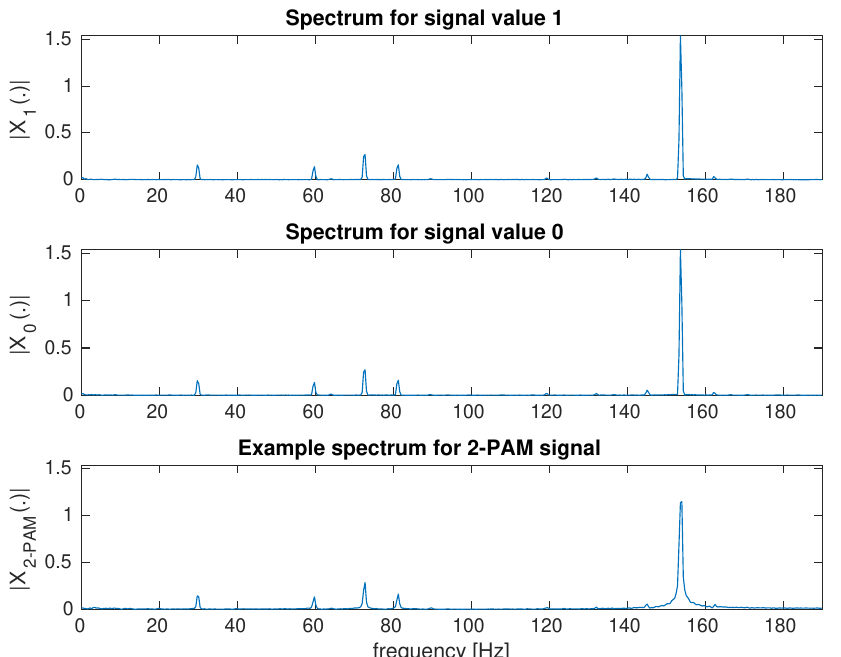
Figure 17. Signal spectra for the average brightness of the frames of the video sequence. Spectra for two brightness levels and a random transmitted sequence with 2-PAM modulation are shown. Brightness modulation with LCD backlight. Scenario with strong brightness disturbances.